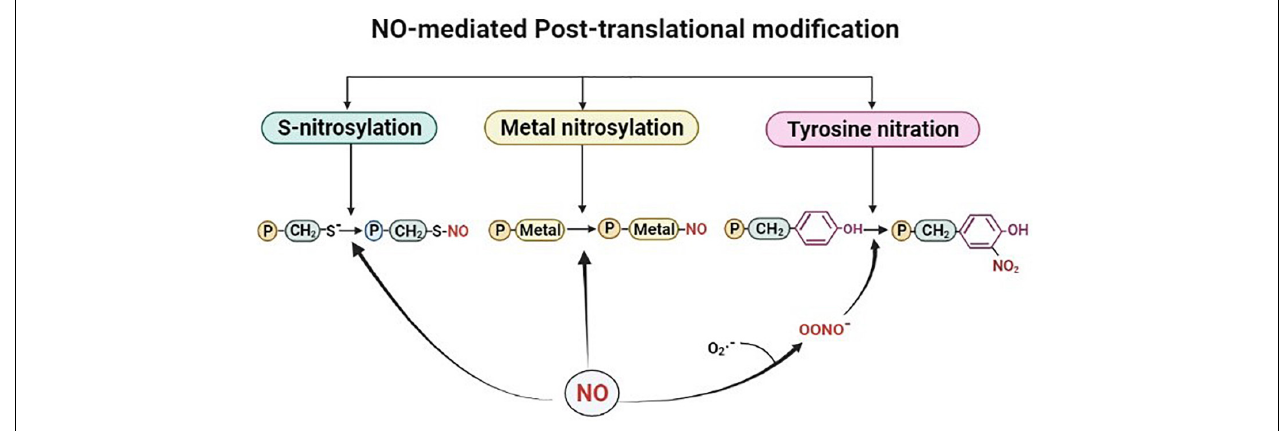
FIGURE 1 | Outline of the nitric oxide (NO)-mediated post-translational modifications. Proteins are represented with letter “P.” Figure made in BioRender.com.